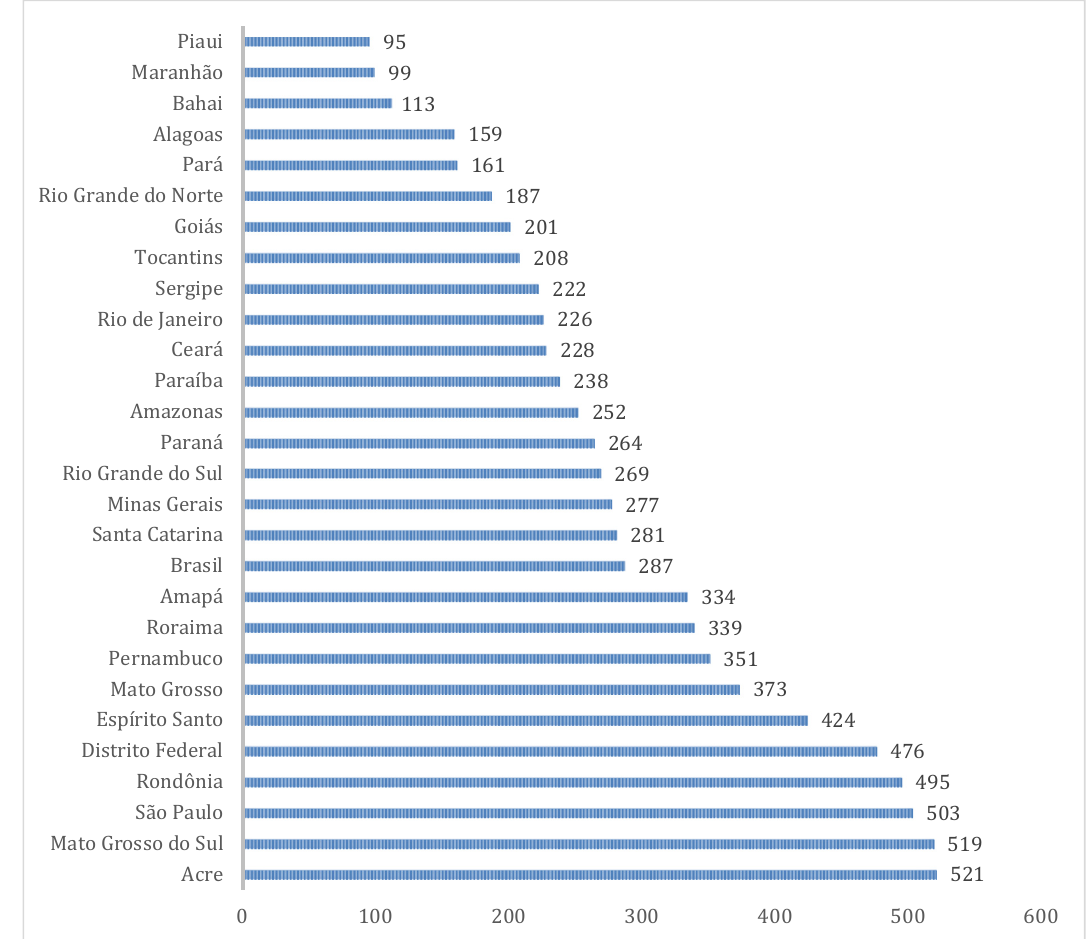
Figure 5: Incarceration rates in Brazil (per 100,000 inhabitants), by State, June 2013 Source: DEPEN